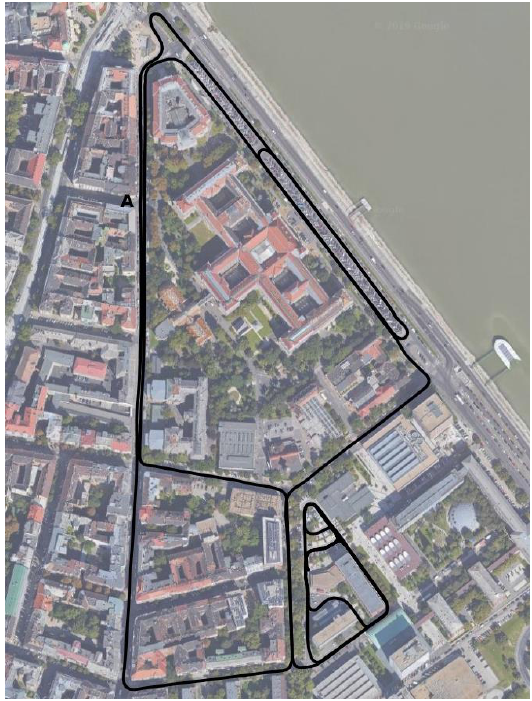
Figure 2. The mobile mapping trajectory in the neighborhood of the BME. The only road with cobblestones can be found in point